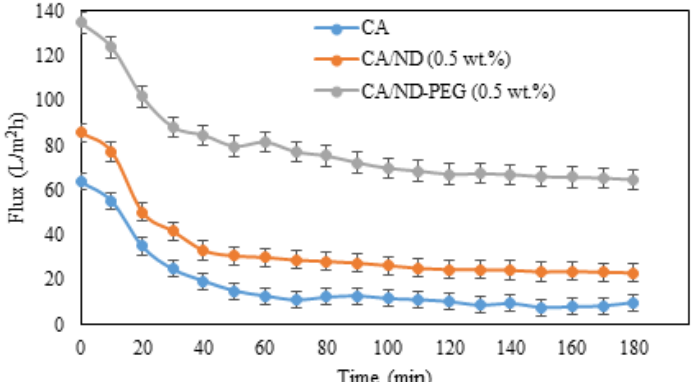
Fig. 8. Flux-time behavior of pure CA, CA/ND (0.5 wt.%), CA/ND-PEG (0.5 wt.%) membranes during filtration of 1 g/L BSA solution.